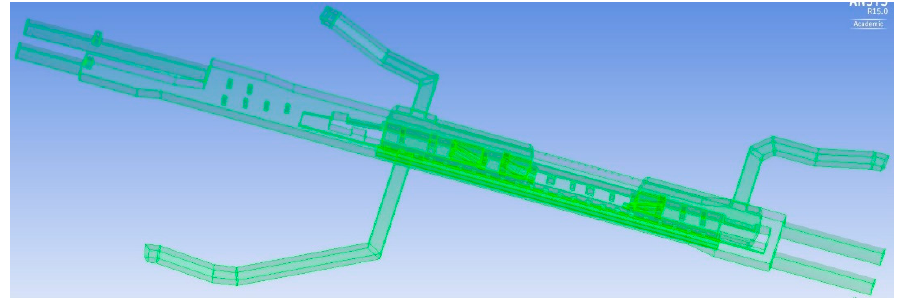
Figure 1. Subway station taken into account in the simulations. The platform of the station is considered to be retrofitted with full-height PSDs on each side toward the subway line, as seen in Figure 2.